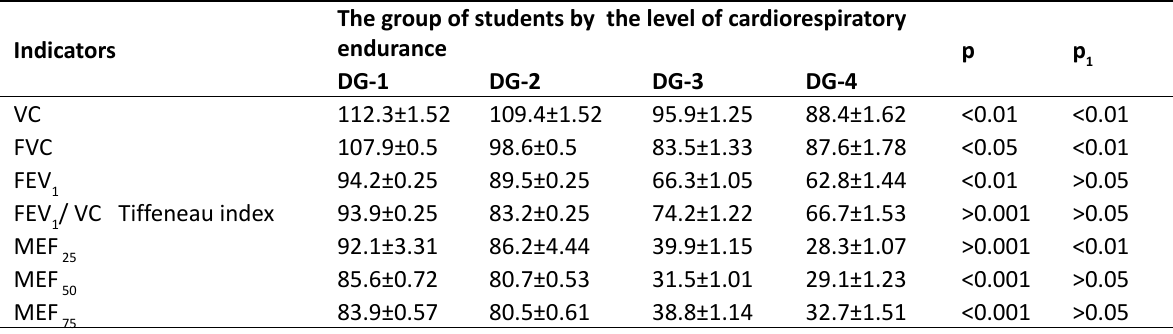
Table 1. Indicators of ventilation lung function in students after a 12-min shuttle run, depending on the level of cardiorespiratory endurance (in % of the proper value, n = 80)